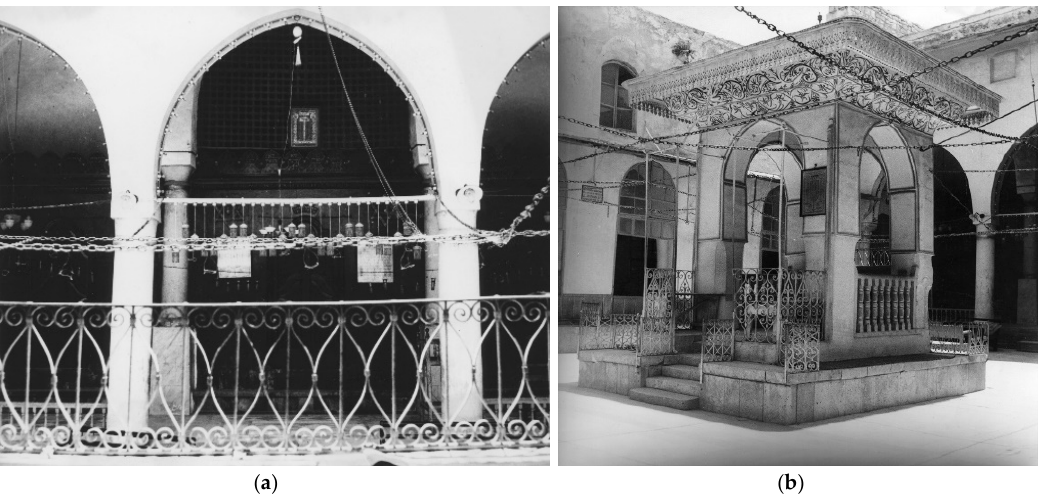
Figure 2. The prayer courtyard in the Great Synagogue of Aleppo, first half of the 20th century. ( a ) three heihalot for Torah scrolls. ( b ) The stone-built teiva . By courtesy of the Photo Archive, the Isidore and Anne Falk Information Center for Jewish Art and Life, The Israel Museum, Jerusalem.